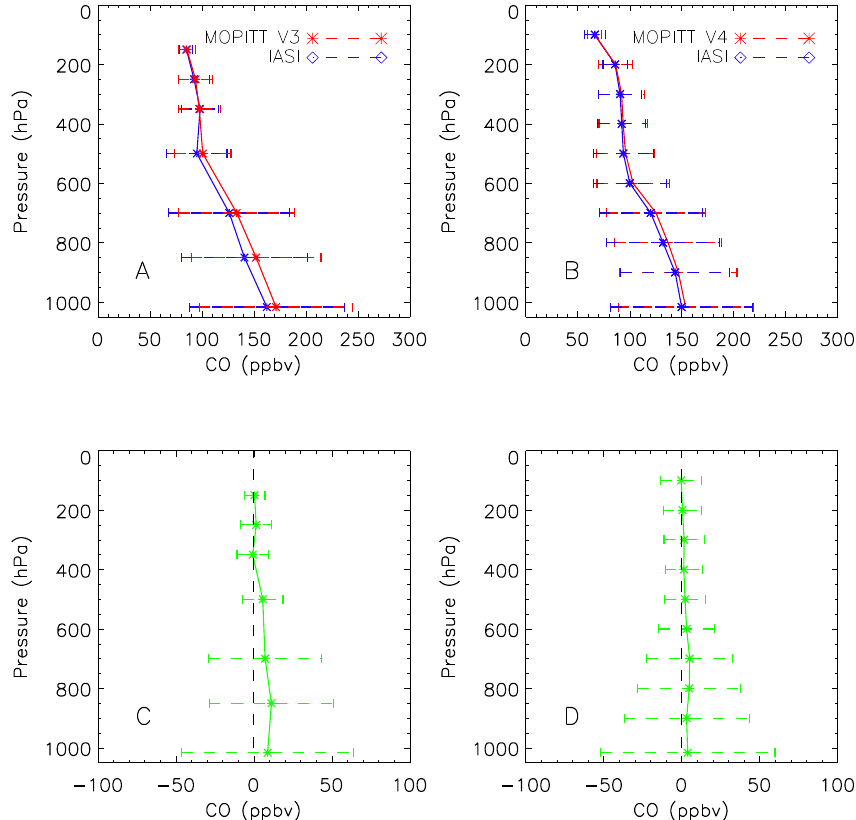
Fig. 12. with reduced smoothing error using the derived quantity in Eq. 7, x MOP’ and x IASI’ : (A) adjusted MOPITT V3 and MOPITT- smoothed IASI CO mean profiles; (B) adjusted MOPITT V4 and MOPITT-smoothed IASI CO mean profiles; (C) the mean difference between adjusted MOPITT V3 CO and MOPITT-smoothed IASI CO profiles; and (D) the mean difference between adjusted MOPITT V4 CO and MOPITT-smoothed IASI CO profiles. All comparisons are for over the ocean and during the daytime of 1 September 2007 , over the Southern Africa region.